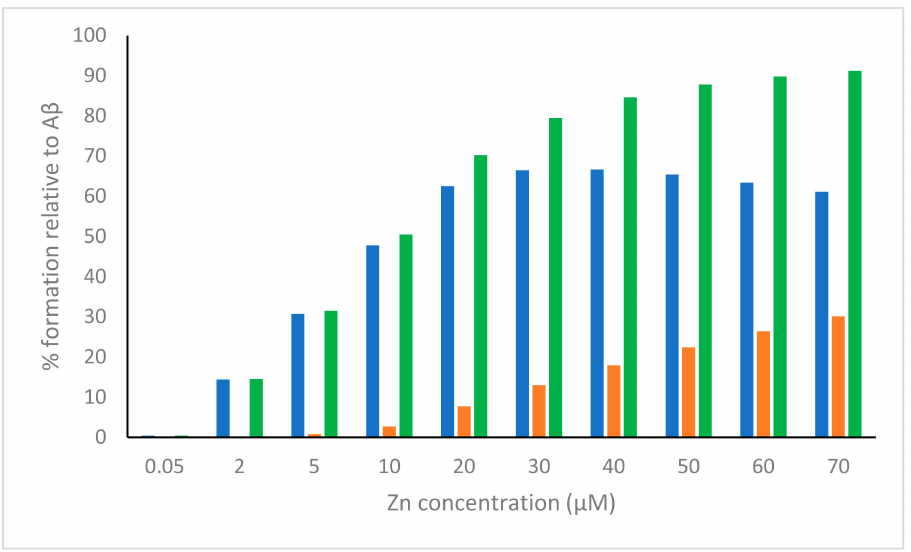
Figure 4. Total percentage of mono-, bi-nuclear species computed at pH = 7.4 for the experiments reported in Figure 6 of [29]. Blue, red and green represent the total percentage of all mono-nuclear, bi-nuclear and mono- plus bi-nuclear species,